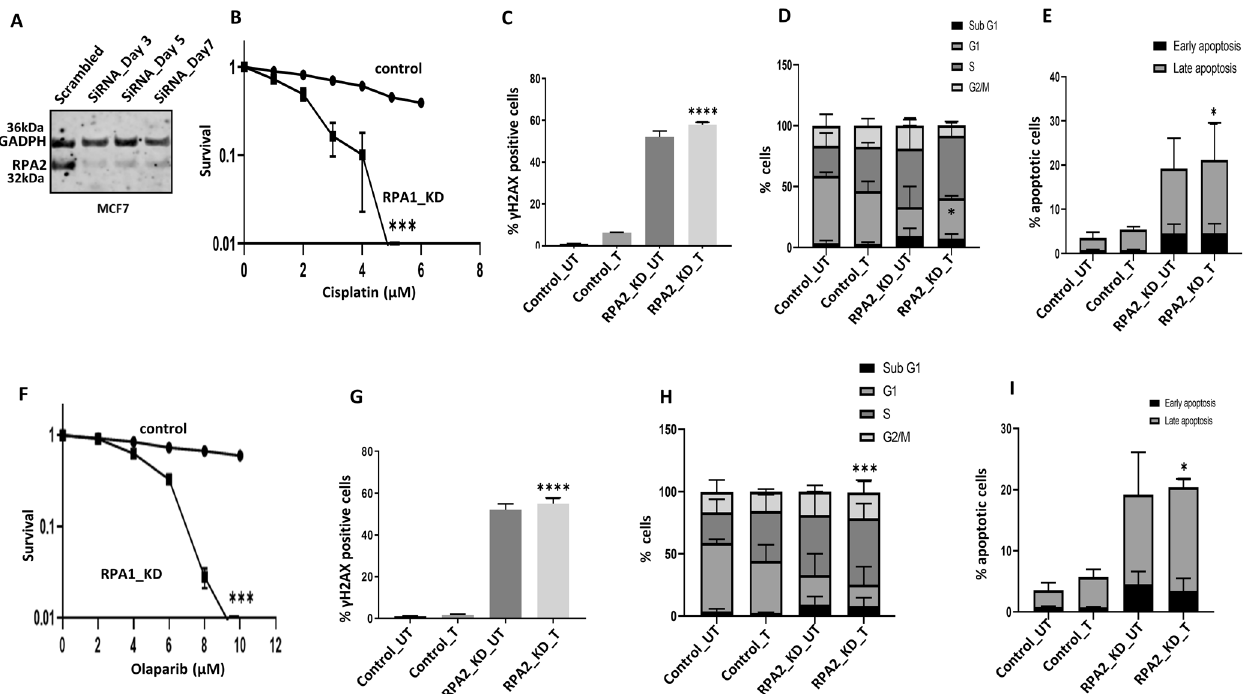
Fig. 6 RPA2 depletion and cisplatin or Olaparib sensitivity in breast cancer cells. A RPA2 siRNA knock down in MCF7 cells. Lysates were collected at day3 and day5. B Clonogenic survival assay for cisplatin sensitivity in MCF7 cells control and MCF7_RPA2_KD cells. C Quanti fi cation of γ H2AX positive cells by fl ow cytometry. D Cell cycle analysis by fl ow cytometry. E Annexin V analysis for apoptotic cells in MCF7 control and RPA2_knock down cells treated with 5 μ M cisplatin for 24 h. F Clonogenic survival assay for Olaparib sensitivity in MCF7